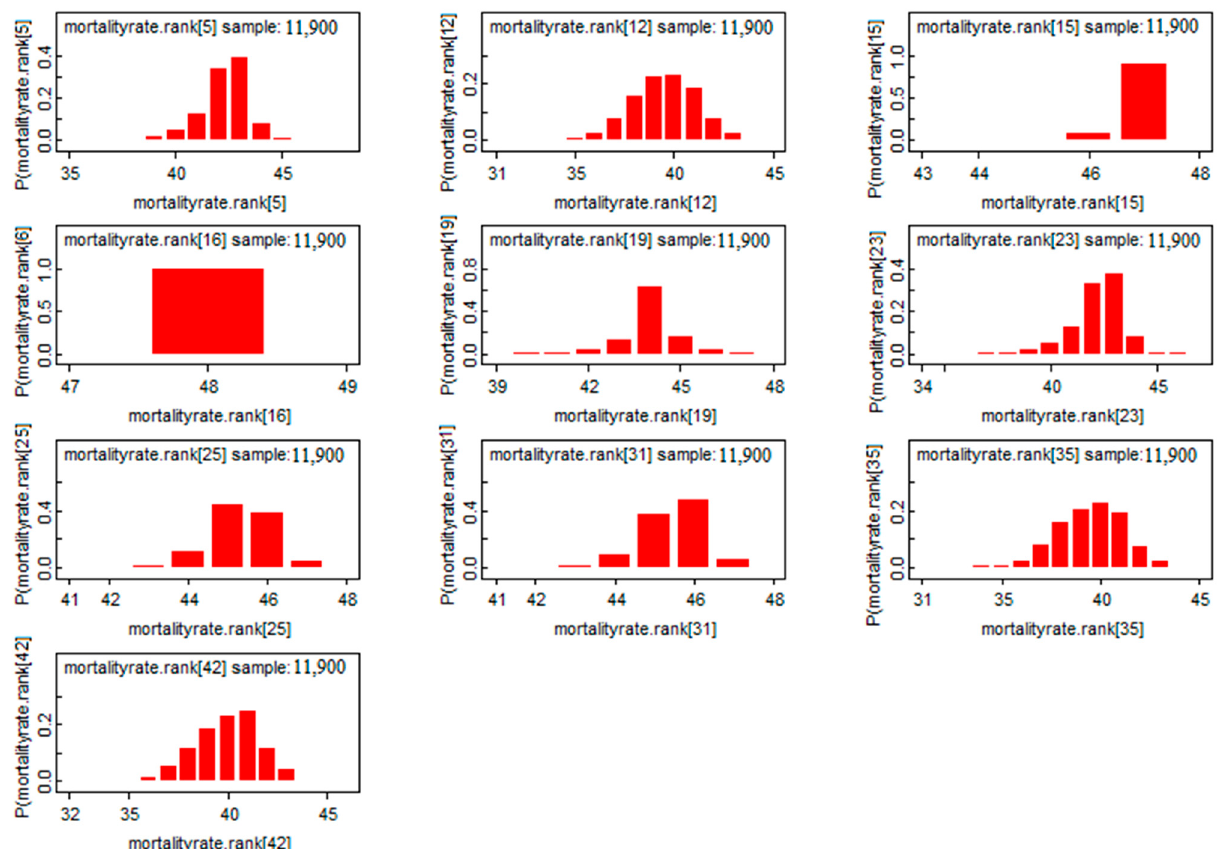
Figure 6. Classification of mortality rates in Algerian provinces (48 provinces) by COVID ‐ 19 be ‐ tween 1 January 2021 and 15 August 2021.